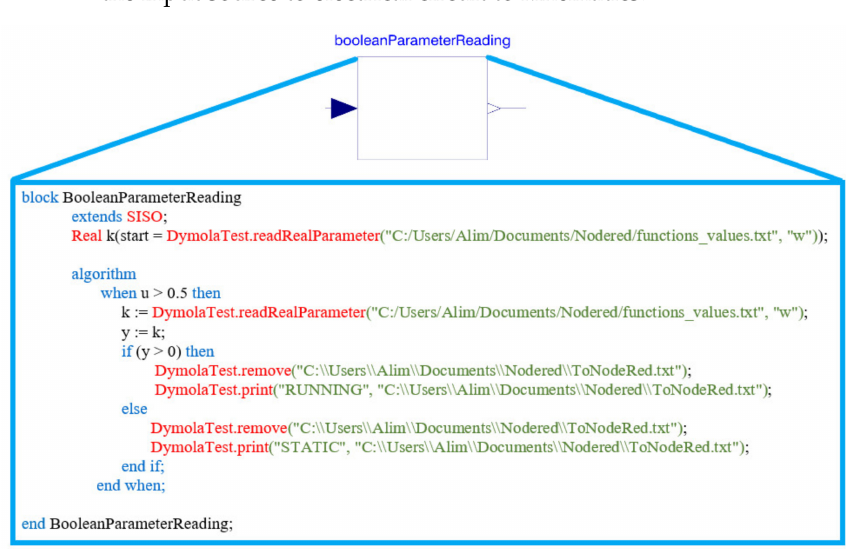
Figure 4. Coded Modelica block for parameter reading and